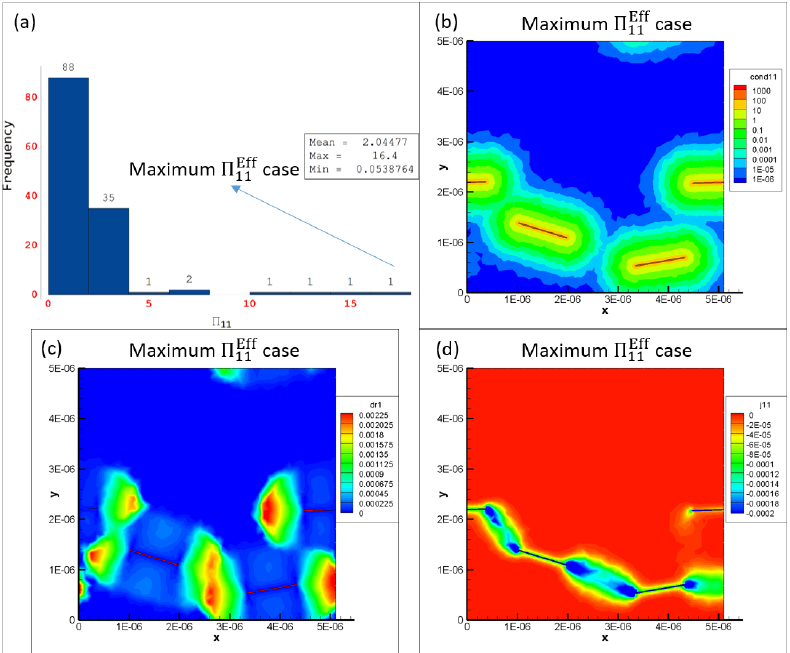
Figure 23. ( a ) Histogram for Π 11 at 0.24% CNT volume fraction for the randomly oriented case with ( b ) local conductivity Σ 11 S/m, ( c ) relative change in resistivity ∆ ρ 1 / ρ 0 and ( d ) current density 1 J 1 A / m 2 for the maximum Π Ef f case at 0.24% CNT volume fraction for the randomly oriented 11